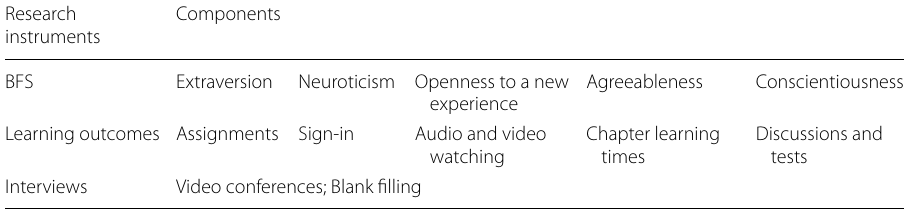
Table 1 Research instruments Research instruments